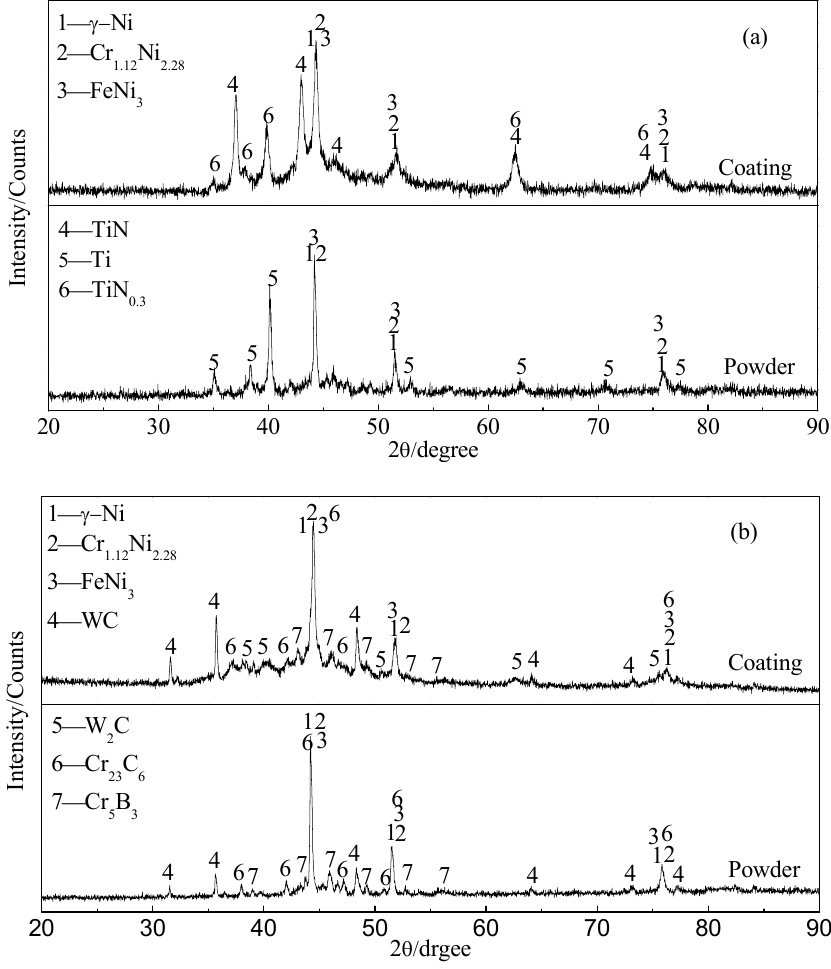
Figure 2. XRD patterns of original powders and composite coatings: ( a ) NiCrBSi–TiN composite (NTC); ( b ) NiCrBSi–WC composite (NWC).